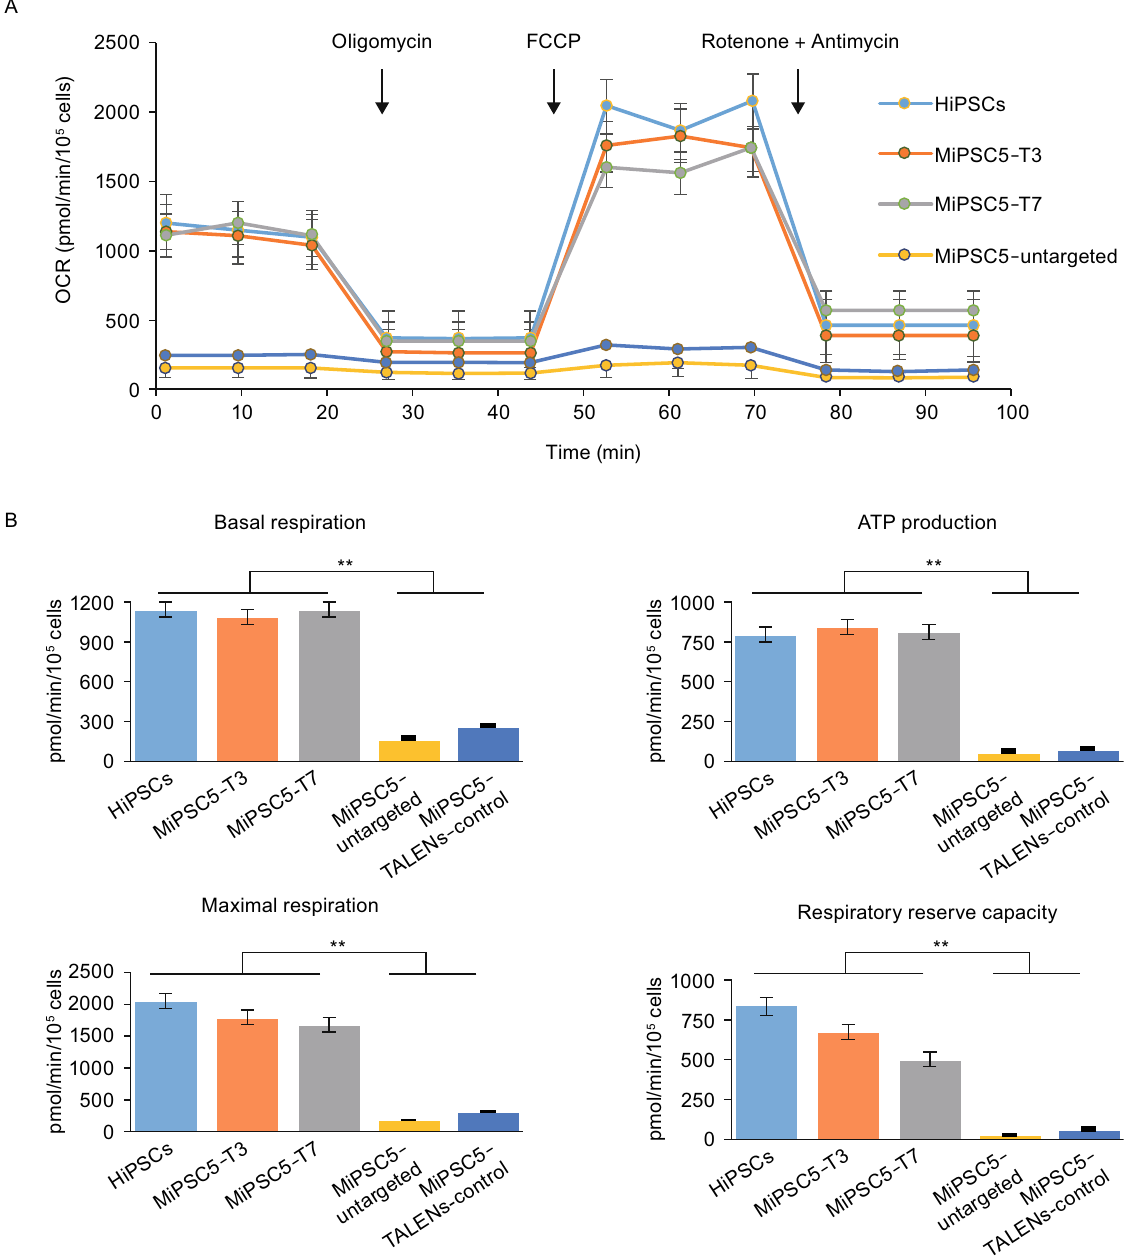
Figure 4. Mitochondrial respiratory function of MELAS-iPSCs and targeted subclones. (A) Mitochondrial function based on in vitro oxygen capacity in response to 0.5 µg/mL oligomycin, 1 µmol/L 4-(tri fl uoromethoxy) phenylhydrazone (FCCP), 0.5 µmol/L rotenone and 1 µmol/L antimycin. (B) Quantitative analysis of basal oxygen consumption, ATP production, maximal respiration and proton leak of iPSCs ( n = 3, error bars represent ±SEM; ** P <